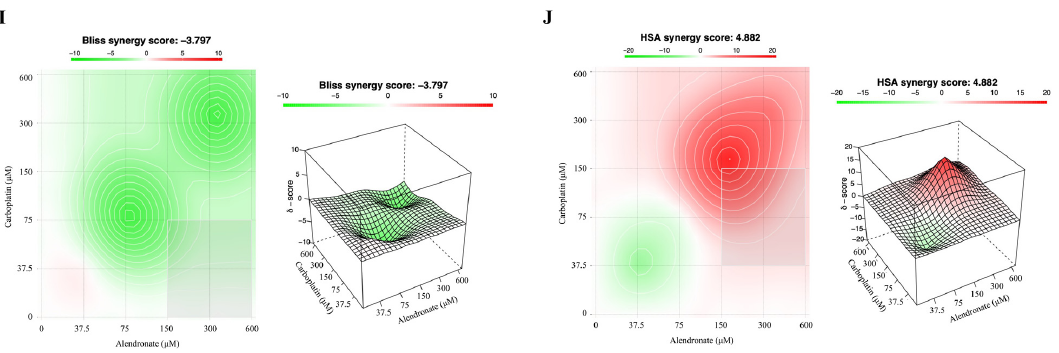
Figure 5. Combining Carboplatin with Pitavastatin or Metformin has a synergistic effect on OVCAR8 PTX R P cells. ( A – J ) Bliss Independence and High Single Agent (HSA) synergy 2D and 3D plots showing drug synergism of OVCAR8 PTX R P cells, after exposure to fixed dose ratios that correspond to 0.25, 0.5, 1, 2 and 4 fold the individual IC 50 values each drug, e.g., Carboplatin combined with ( A , B ) Pitavastatin, ( C , D ) Metformin, ( E , F ) Ivermectin, ( G , H ) Itraconazole and ( I , J ) Alendronate for 48 h. The combined treatment was co ‐ administered at the same time. All assays were performed in triplicate in at least three independent experiments. Synergy score: < − 10 (antagonism, green), − 10 to 10 (additivity, white) and >10 (synergism, red).